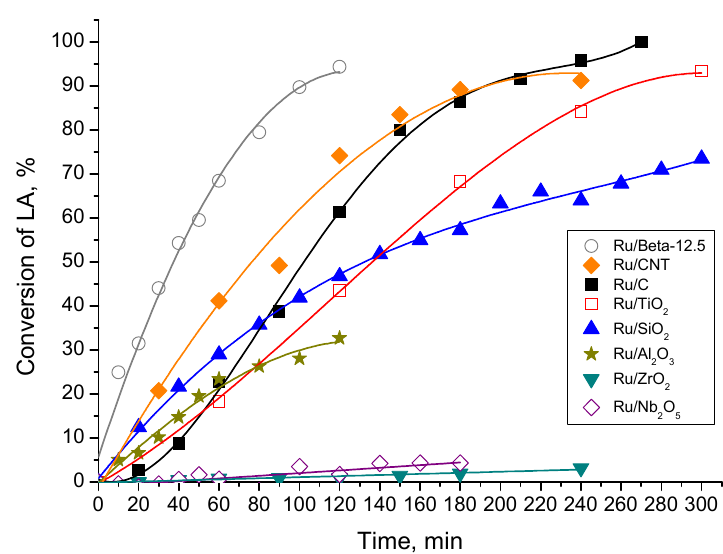
Figure 3. LA conversion in the reaction with Ru-based catalysts (1 wt. % Ru). Reaction conditions: 90